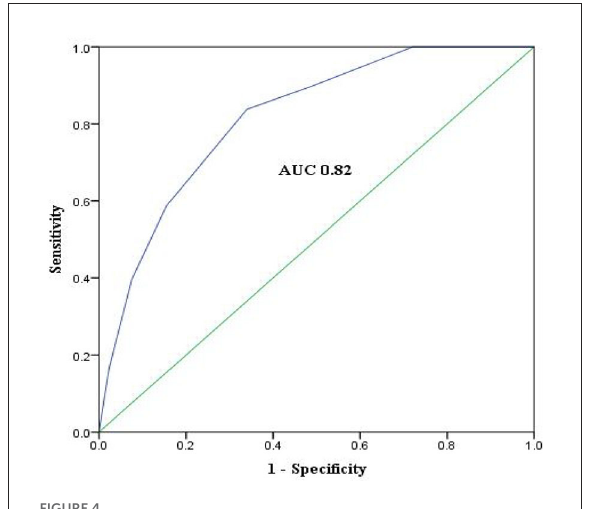
FIGURE4 ROC curves of the derivation